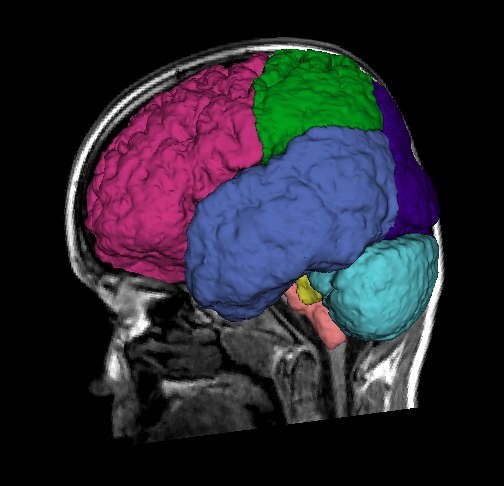
3D rendering of parcellation of a 9-year-old child’s brain from MRI. The surface model is depicted on top of a mid-sagittal slice from the T1-weighted MRI. Comparison of regional tissue volumes across subjects can be employed to indicate localized structural differences.